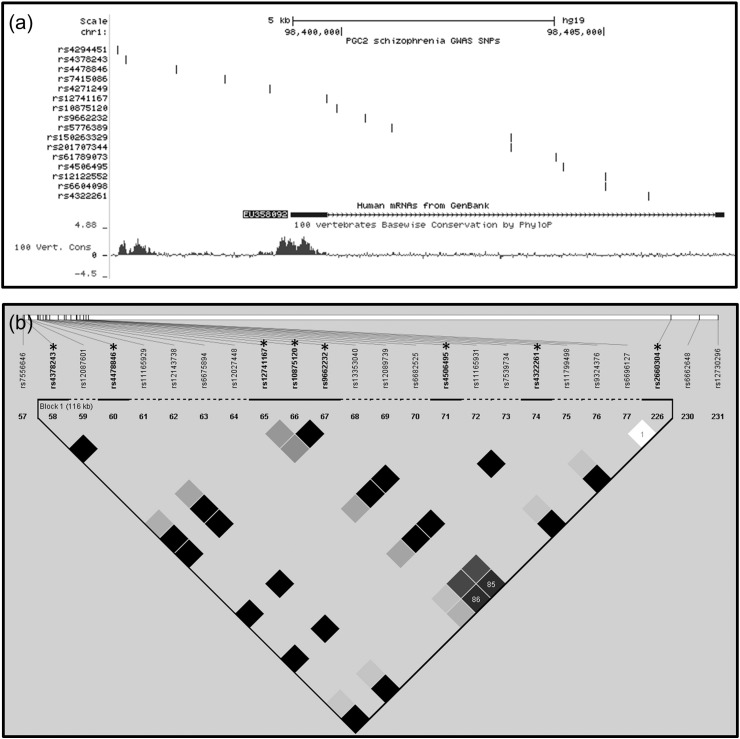
Linkage disequilibrium (LD) analysis of SNPs across the EU358092 locus.(a) Schematic representation of the EU358092 locus and identified ECRs, in relation to 16 schizophrenia GWAS SNPs across this locus. Two schizophrenia GWAS SNPs (rs4294451 and rs4378243) are within EU358092 ECR 2 (EU2), and may therefore modify the function of this conserved element, or tag this as a region of functional interest.(b) LD analysis of SNPs at EU358092 was carried out using SNP genotype data from the HapMap CEU cohort with D′ values. Data for seven of the 16 schizophrenia GWAS SNPs (starred*) was available in this HapMap cohort. The remaining non-GWAS HapMap SNPs were included in the above plot, however the minor allele frequency data for these SNPs was not sufficient to assess LD. All schizophrenia GWAS SNPs at this locus, with the exception of the EU359082 splice site SNP rs12741167, were in complete LD and form a haplotype block as defined by Gabriel et al. (Gabriel et al., 2002). The schizophrenia GWAS SNPs at EU358092 were in LD with the schizophrenia GWAS SNP rs2660304 at the MIR137 internal promoter. The functional significance of the GWAS across this locus may be highlighting either EU358092 or MIR137, which may be acting separately or synergistically to influence the association across this locus with schizophrenia.